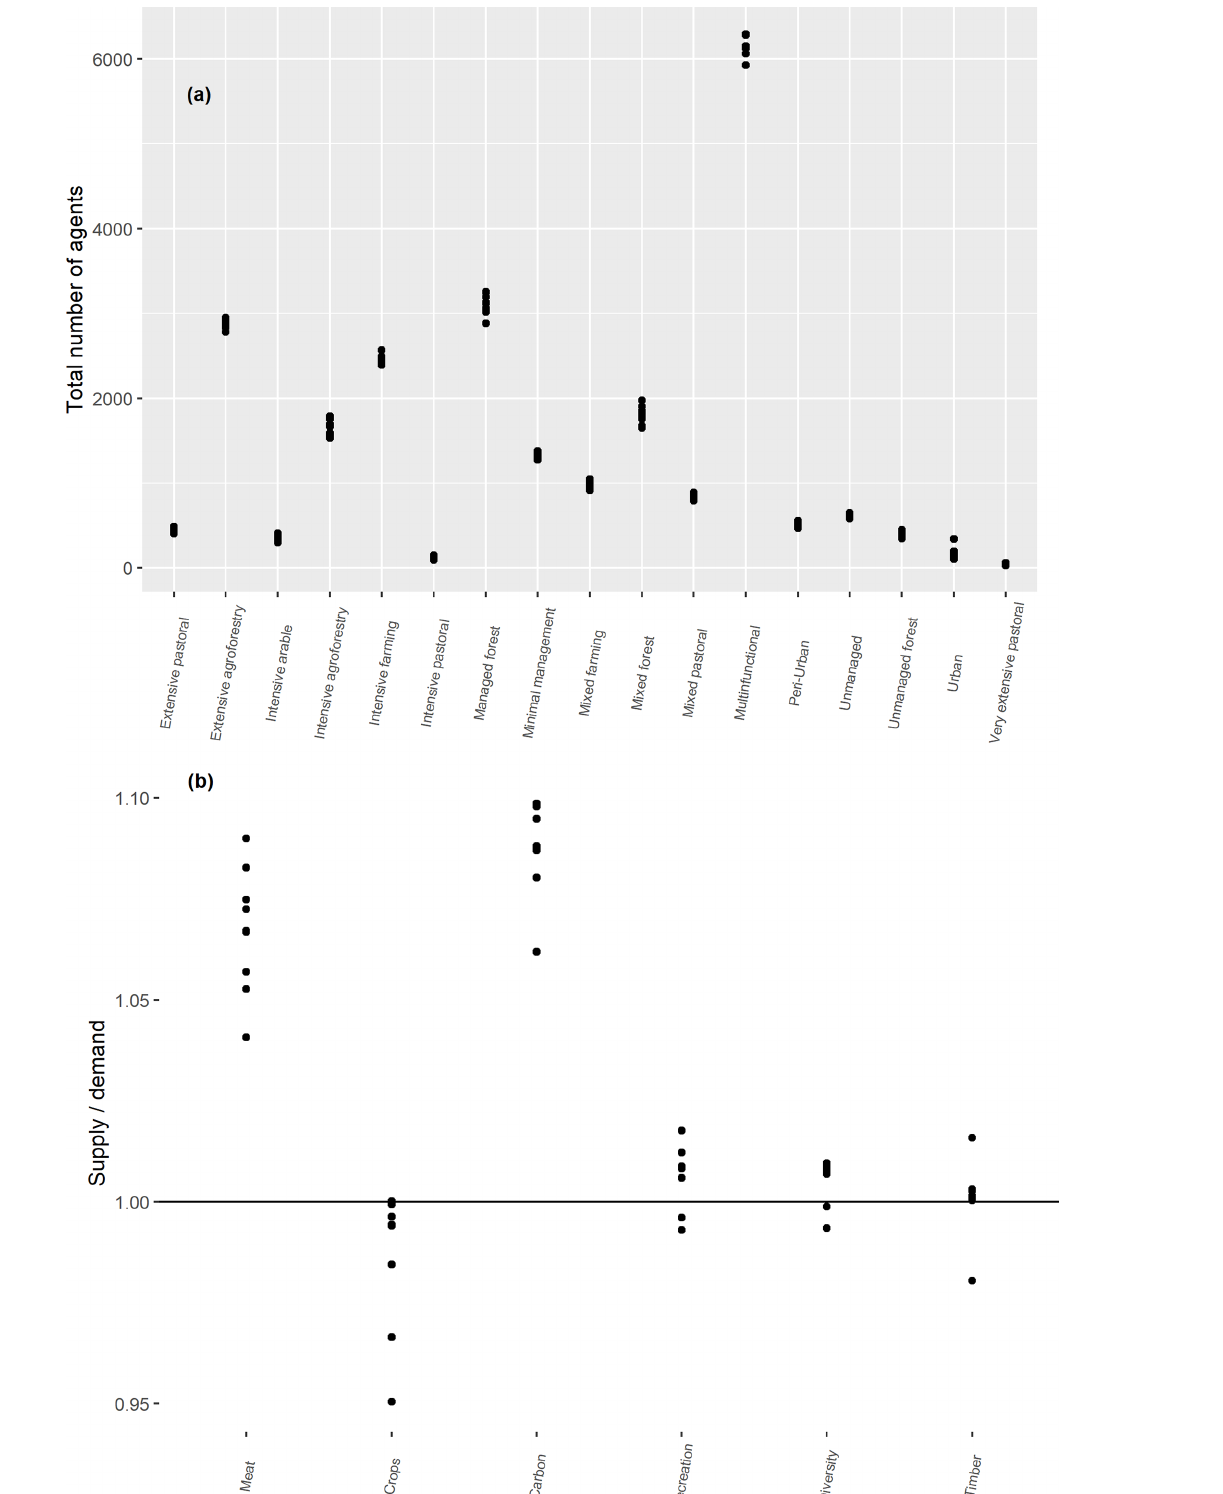
Figure B2. Numbers of agents belonging to each agent functional type at the 300th time step of each of the 10 independent simulations with no initial land use map (a) and service levels as a proportion of demand levels at the same points (b) .